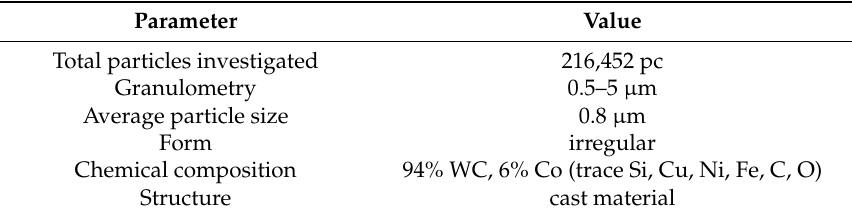
Table 1. Characteristics of the finished mixture of micron WC and Co nanopowder.